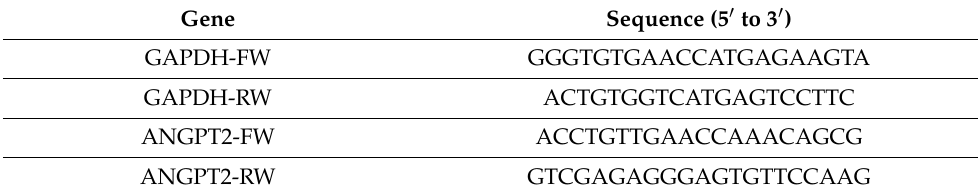
Table 1. Primer sequences for quantitative PCR. Gene Sequence (5 (cid:48) to 3 (cid:48) ) GAPDH-FW GGGTGTGAACCATGAGAAGTA GAPDH-RW ACTGTGGTCATGAGTCCTTC ANGPT2-FW ACCTGTTGAACCAAACAGCG ANGPT2-RW